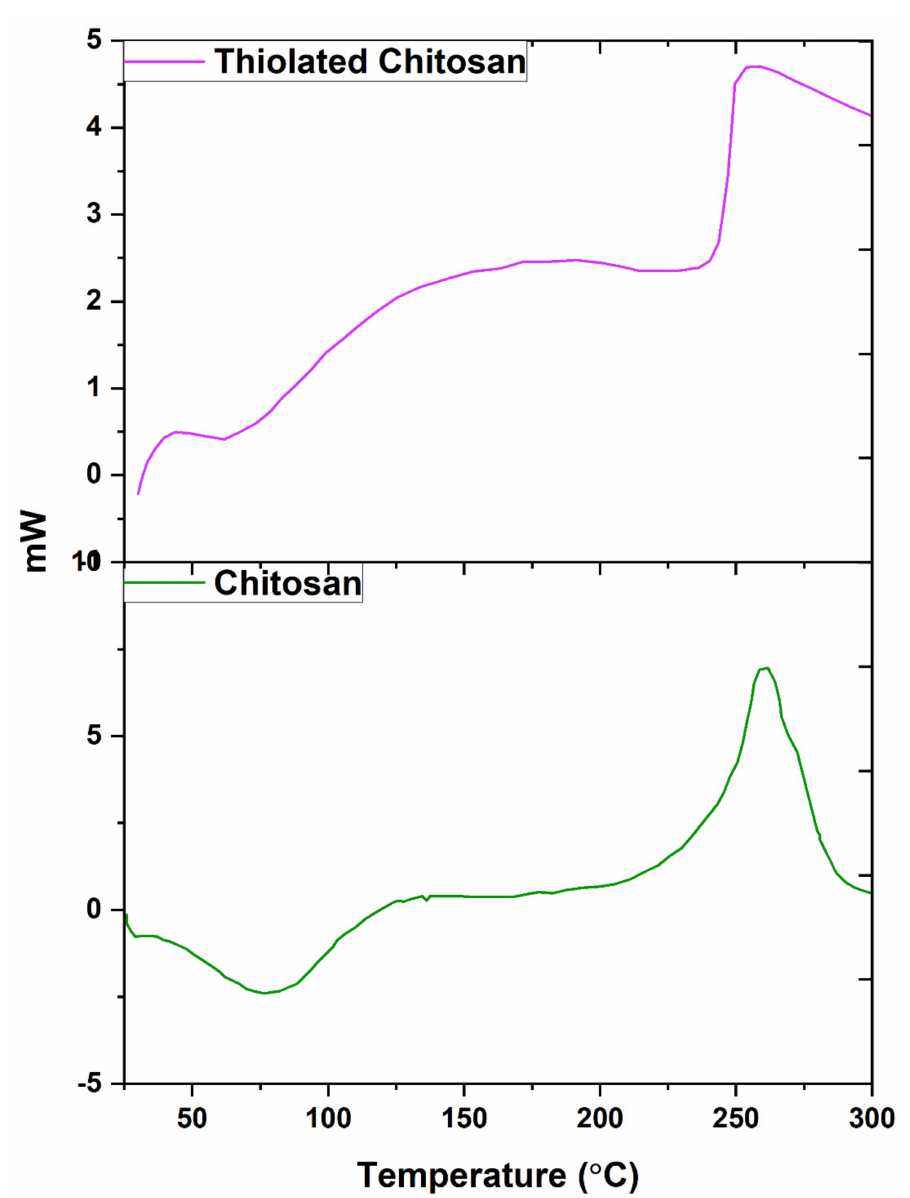
Figure 4. Differential scanning calorimetry thermogram of chitosan and thiolated chitosan synthe- sized by covalent bond formation between thioglycolic acid and chitosan via EDAC